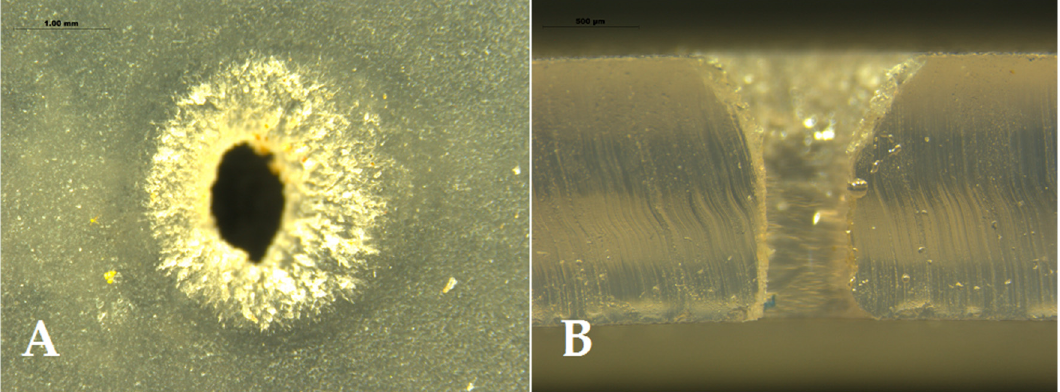
Figure 9. Some examples of the level of damage observed in the silicon diaphragms of emitters belonging to the control tubing (Block 2). ( A ) Upper view of a damaged diaphragm, showing prominent erosion marks around the inner orifice; ( B ) lateral view of the transversal cut of another emitter, with a deep “truncated cone”.